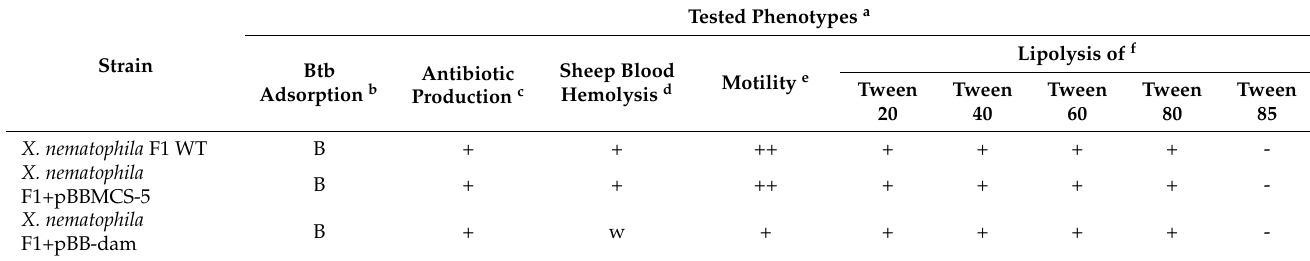
Table 2. Phenotypes of X. nematophila F1 overexpressing dam gene (pBB-dam) and control (pBBMCS-5).